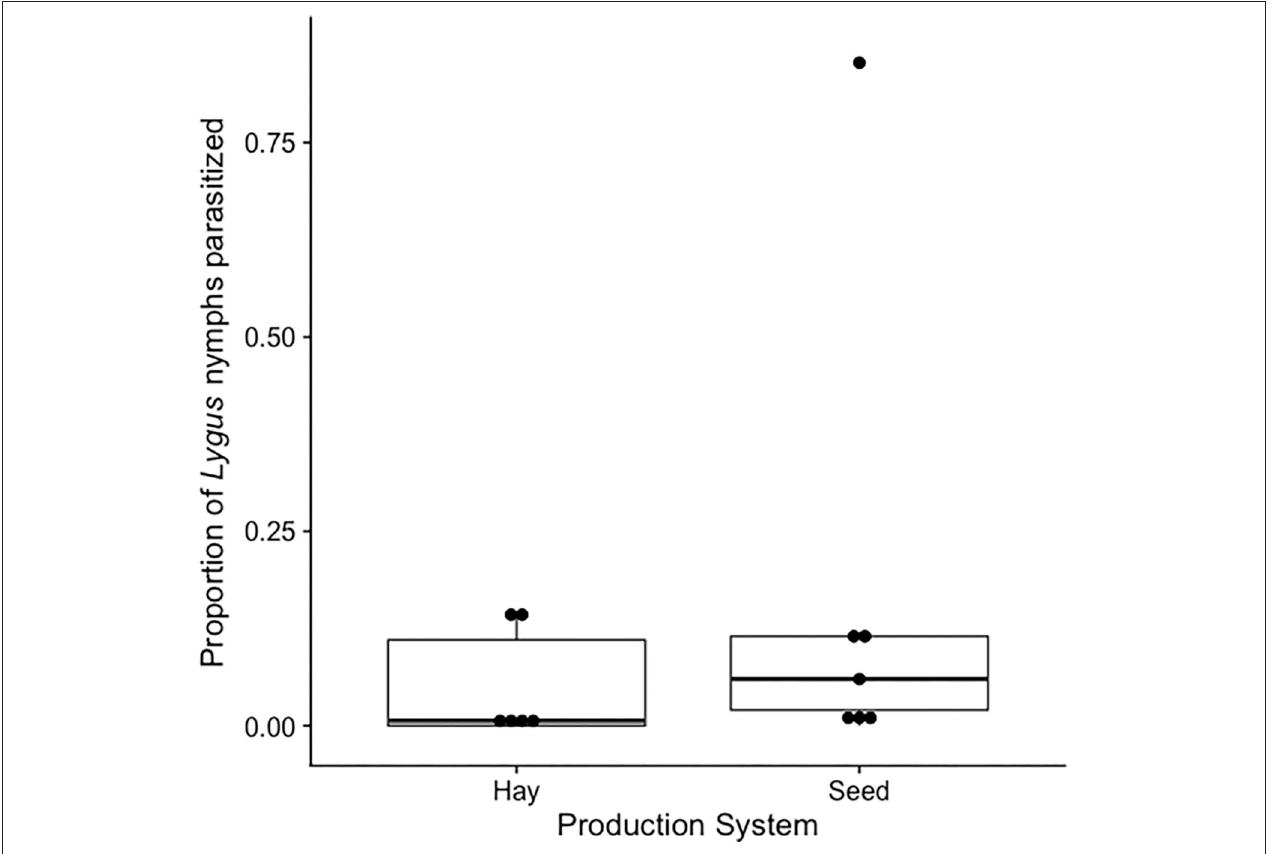
FIGURE 5 | Proportion of Lygus late-instar nymphs parasitized by wasps in July